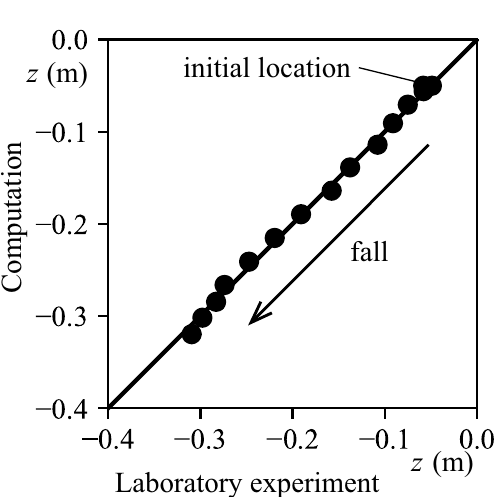
Figure 7. An example of an underwater drop test. Comparison of drop locations between the laboratory experiment and computation. The water surface corresponds to z = 0